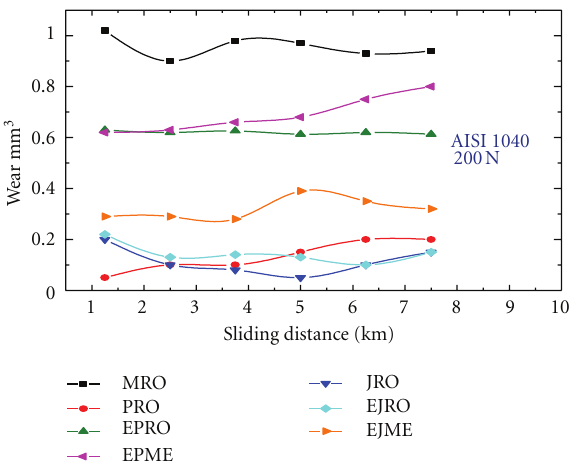
Figure 8: Variation of wear with sliding distance for 200 N.